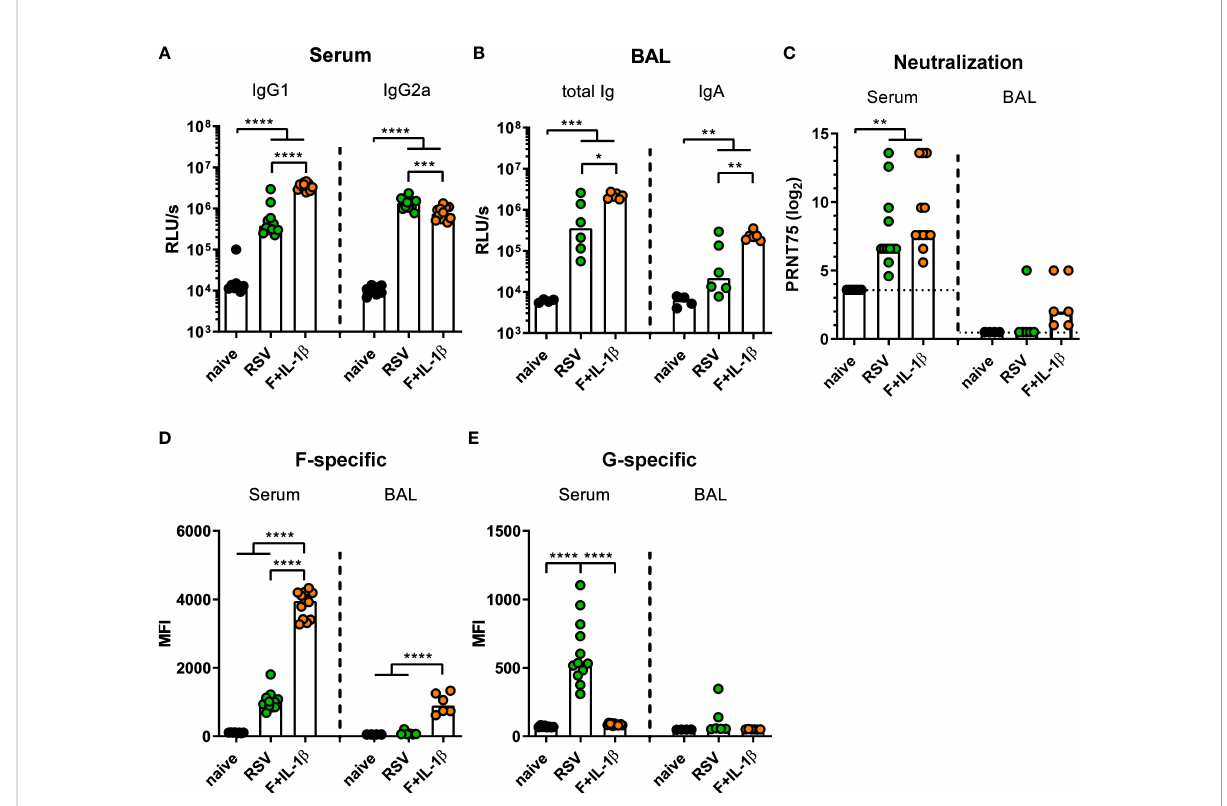
FIGURE 4 Humoral responses induced by mucosal vaccination or primary RSV infection. BALB/cJRj mice were infected with 5x10 5 PFU RSV-A2 or immunized with 2x10 8 particles Ad-F and 1x10 9 particles Ad-IL-1 b . Antibody levels were characterized in sera 35 days and in BAL samples 42 days post-immunization. (A, B) Virus-speci fi c IgG1 and IgG2a in sera (A , 1:1000 dilution ) and Ig and IgA in BAL (B , 1:10 dilution ) were detected via virus-coated ELISA. (C) 75% plaque reduction neutralization titers (PRNT75) in sera (detection limit at a titer of <1:12, dotted line) and BAL (detection limit at a titer of <1:2, dotted line) were tested by microneutralization assay. (D, E) FACS-based analysis for F- (D) and G-speci fi c (E) antibodies was performed in sera (1:100 dilution) and BAL samples (1:20 dilution). Bars represent group medians (A-C) or means (D, E) overlaid with individual data points. n=8-12 for sera and n=4-6 for BALs. Data were analyzed by one-way ANOVA followed by Tukey´s post test (values in A-C were log-transformed before analysis). * p <0.05, ** p <0.005, *** p <0.0005, **** p <0.0001. Relative light units per second,